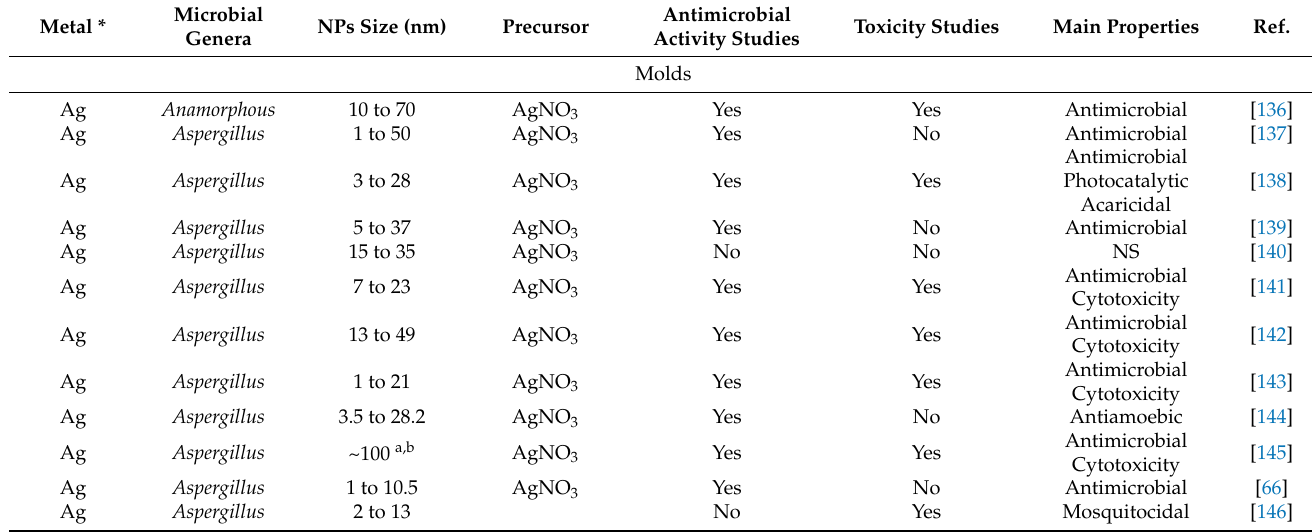
Table 2. Biosynthesis of metal nanoparticles using fungi. Several examples of literature published in the last five years (2018–2022). The microbial genera, the metal and its precursor and the size of the metal nanoparticles obtained are presented. It is also stated whether the antimicrobial activity and toxicity of the nanoparticles were tested and which properties were